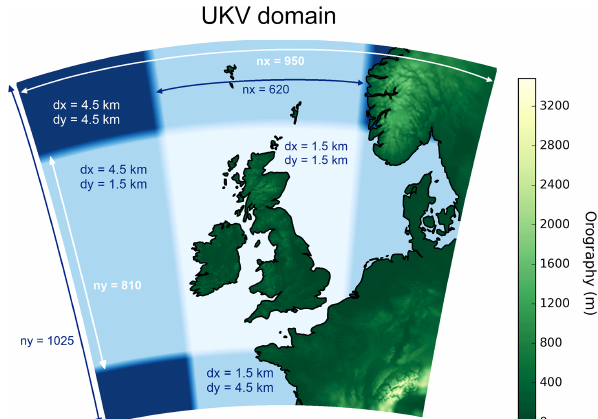
Figure 1. Domain for UK case studies.